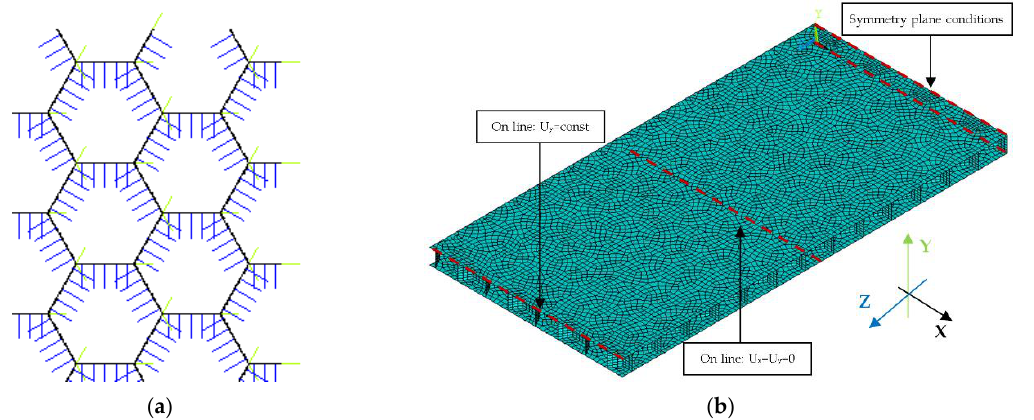
Figure 7. Orientation of local coordinate system in elements ( a ) and applied boundary conditions ( b ).